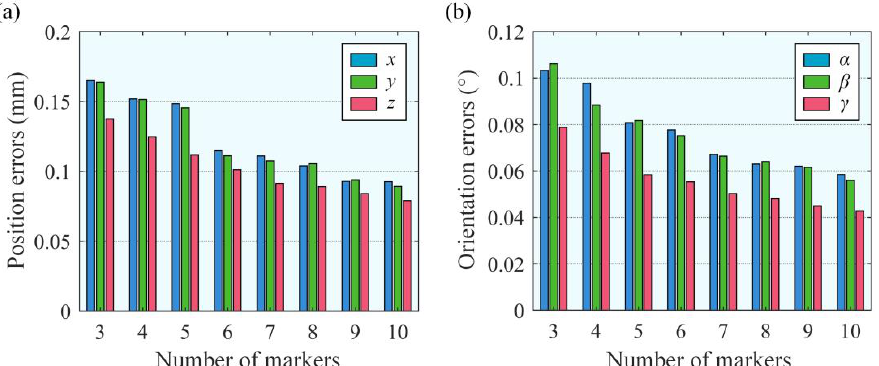
Figure 5. Recognition errors in ( a ) position and ( b ) orientation using different numbers of markers. In the same group, the recognition error of position parameter z and orientation parameter are slightly smaller than those of other position and orientation parameters.